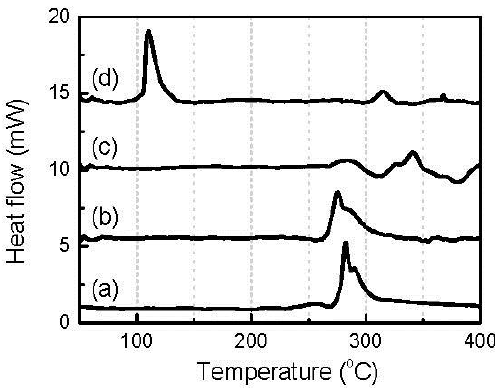
Figure 8. DSC curves of ( a ) 1 µ L 1 mol dm − 3 LiPF 6 /EC-DMC electrolyte; ( b ) 0.17 mg LiF with 1 µ L electrolyte; ( c ) 0.37 mg nano-Fe with 1 µ L electrolyte; and ( d ) 0.20 mg Li 2 O with 1 µ L electrolyte, respectively.